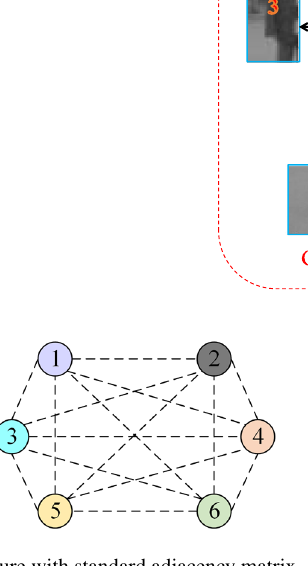
encoder–decoder structure for feature propagation between backbone and GRAN, and the entire network can achieve end-to-end